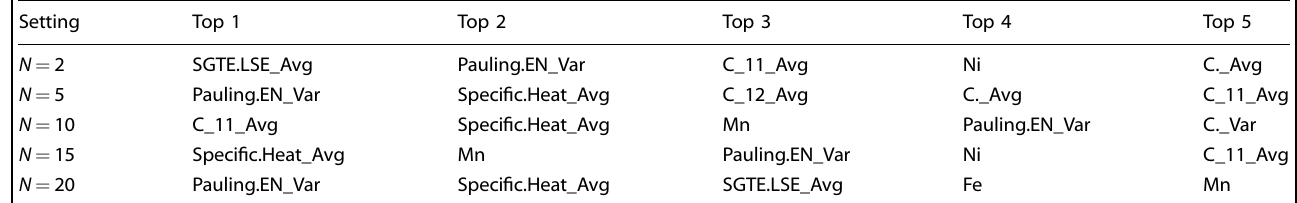
Table 8. The top fi ve important factors selected by BMARS for the maximum stacking fault energy (SFE) with the initial set of sample size N ∈ {2, 5, 10, 15,